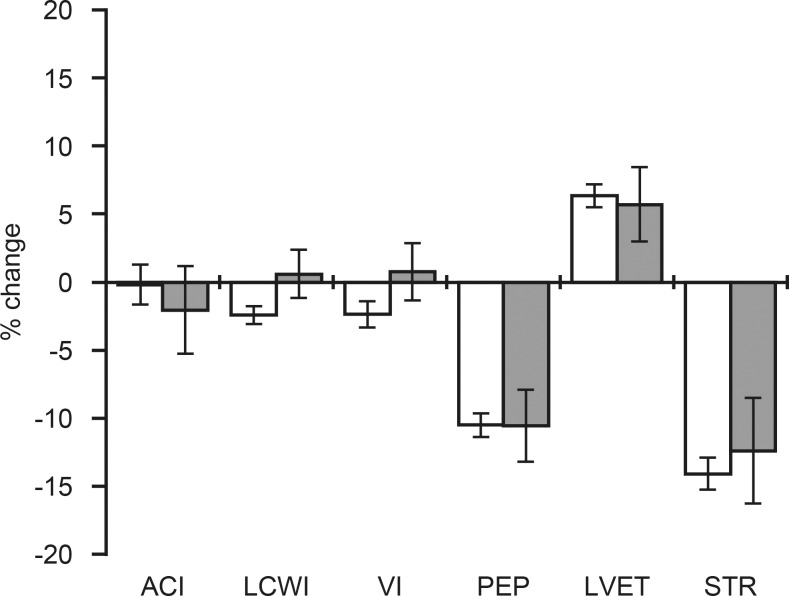
Differences in cardiac contractility and work between pregnant women with normal and high UtA PI.Data presented as mean ±standard error of mean (SEM). Percent change from baseline to passive leg raising. Normal (white bars) and high (grey bars) UtA PI. Acceleration index (ACI), left ventricular work index (LWCI), velocity index (VI), pre-ejection period (PEP), left-ventricular ejection time (LVET), and systolic time ratio (STR).